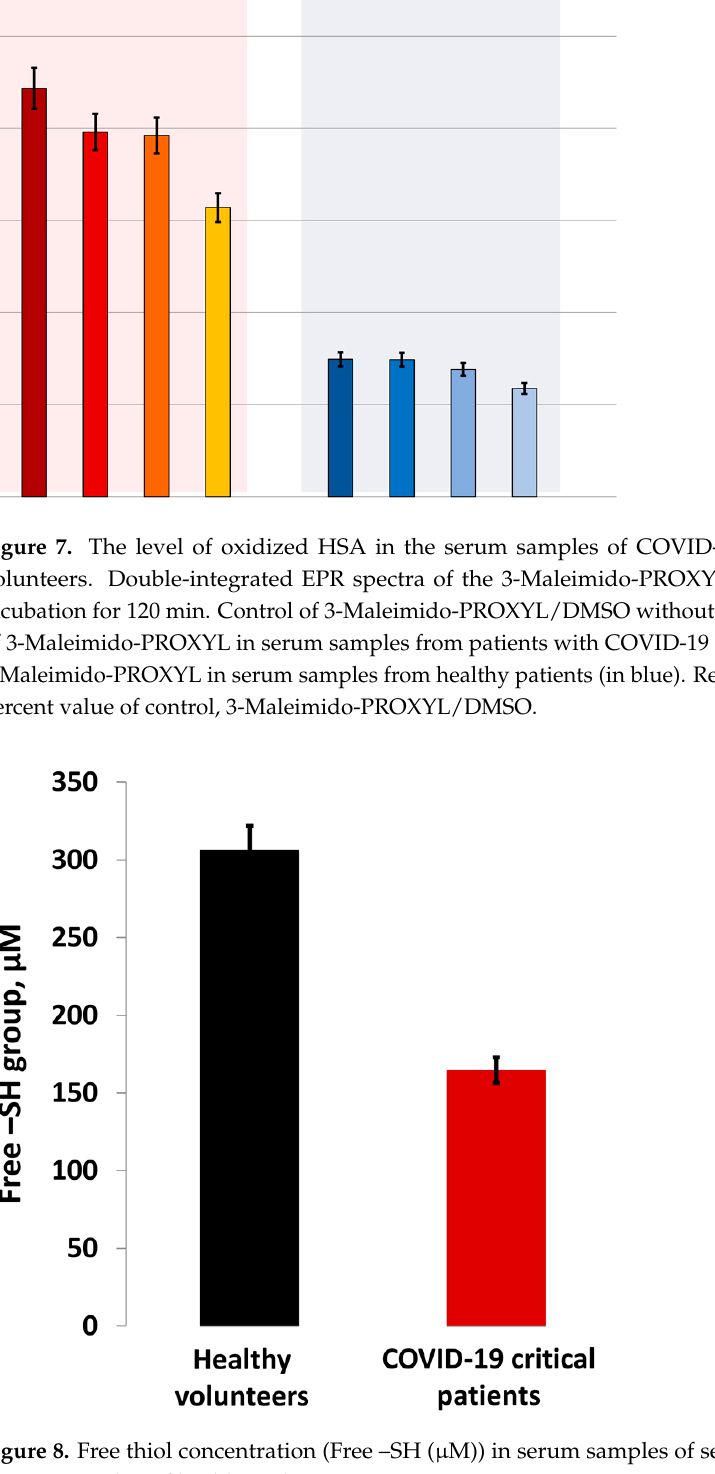
Figure 8. Free thiol concentration (Free –SH (µM)) in serum samples of severe COVID-19 patients compares to that of healthy volunteers.